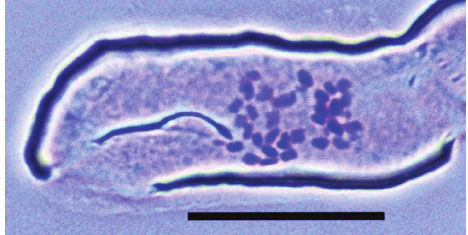
Figure 11. Centaurea ambigua Guss. subsp. ambigua , 2 n = 36. Scale bar: 10 μm.